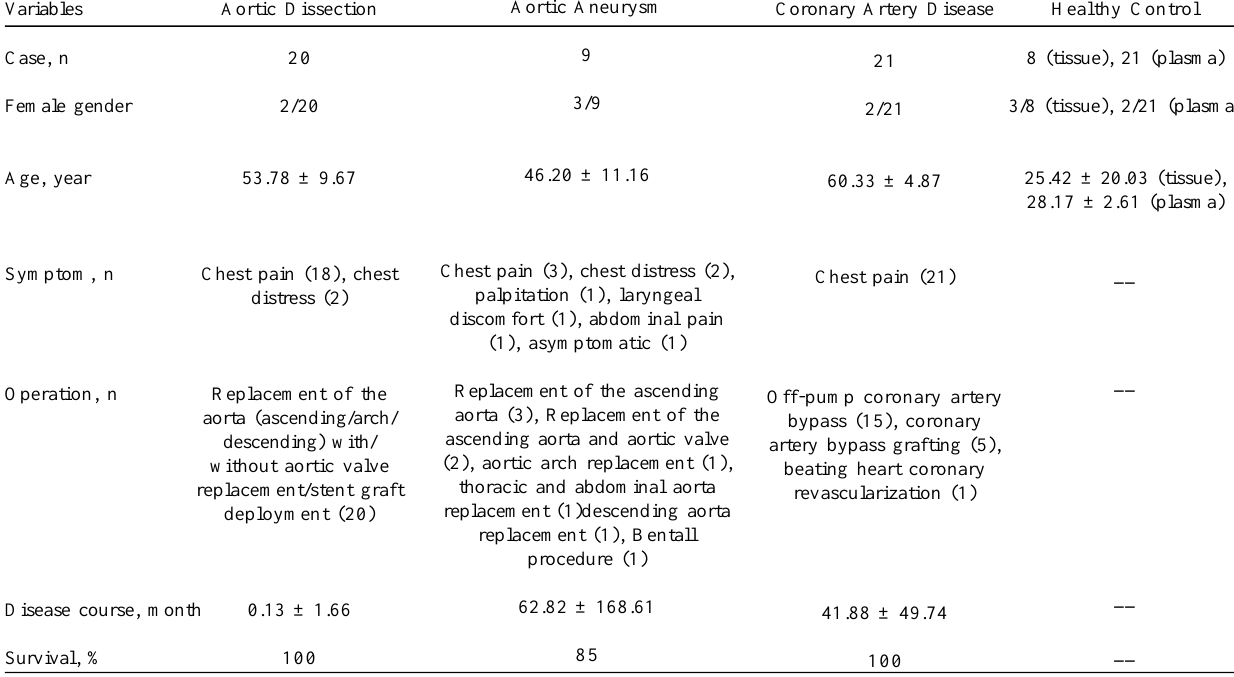
Table 1. Demographic